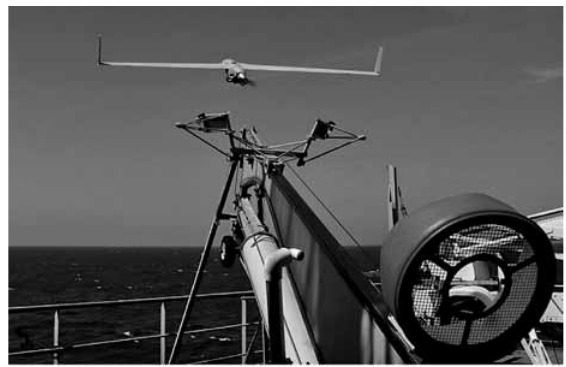
Fig. 4. ScanEagle UAV monitoring arctic